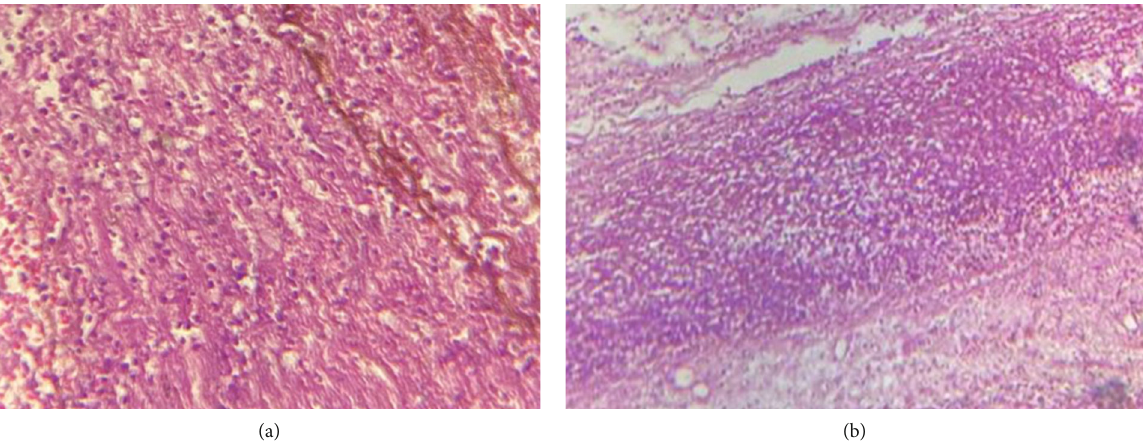
Figure 3: (a, b) Histopathological micrographs of partial gastrectomy